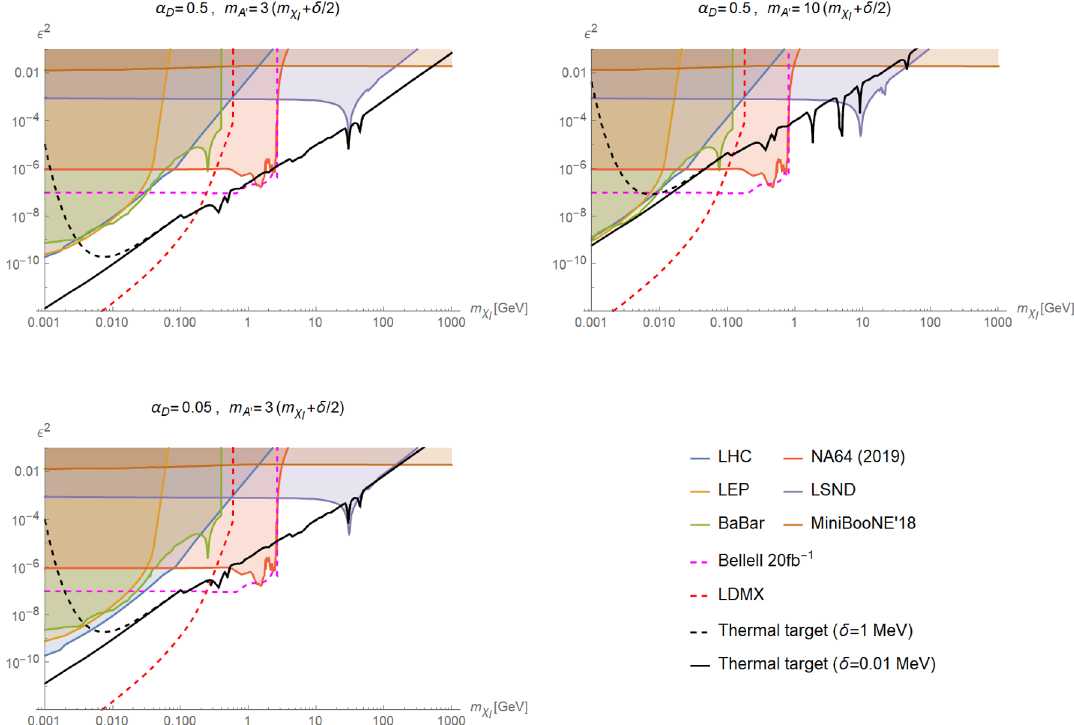
Figure 21 . Current bounds and projections from fixed-target experiments for a thermal target with MeV ans sub-MeV mass splitting, as in figure 6 but for different values of α We note that the exclusions become stronger for smaller α 2 the ability to constrain most of the sub-GeV